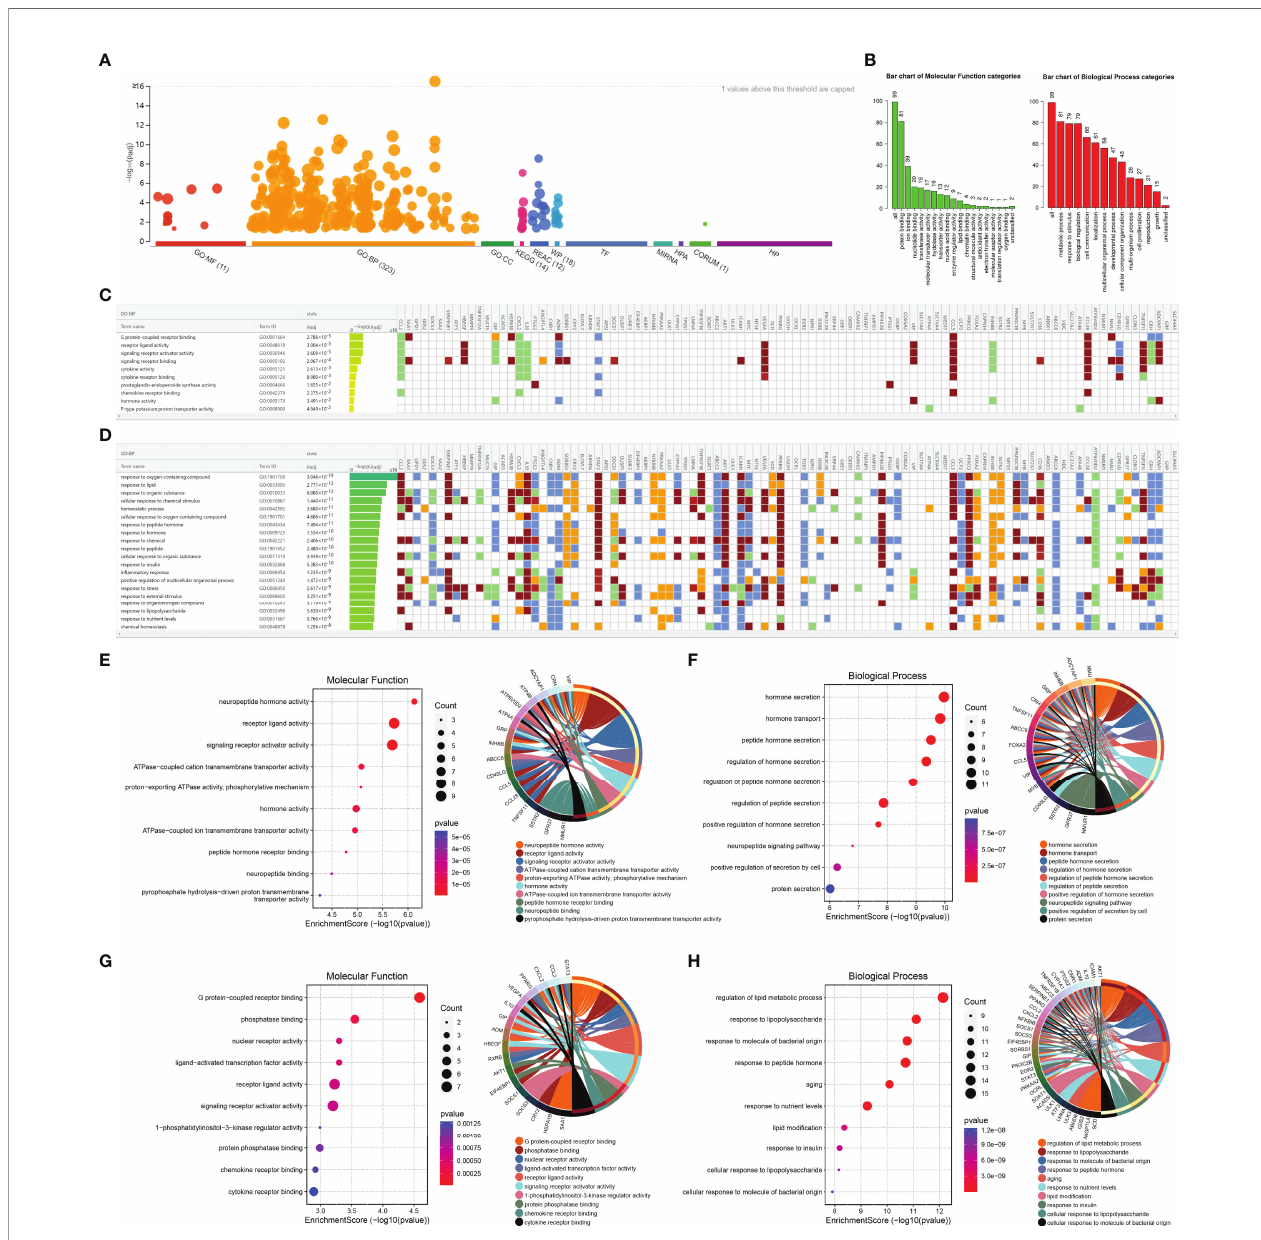
FIGURE 2 | GO analyses of ORDEGs between OLF and control samples. (A) Manhattan plot showed a signi fi cant dysregulation in all categories, which included GO with 11 signi fi cant pathways for MF, 323 signi fi cant pathways for BP, 14 signi fi cant pathways for KEGG, 12 signi fi cant pathways for REAC, and 18 signi fi cant pathways for WP. (B) WebGestalt annotated the number of genes enriched in different pathways of MF and BP. (C) Pro fi ler analysis indicated the GO terms analysis in MF. (D) Pro fi ler analysis indicated the GO terms analysis in BP. (E) GO histogram plot and cnetplot show the enriched functions of up-regulated genes in MF. (F) GO histogram plot and cnetplot show the enriched functions of up-regulated genes in BP. (G) GO histogram plot and cnetplot show the enriched functions of down-regulated genes in MF. (H) GO histogram plot and cnetplot show the enriched functions of down-regulated genes in